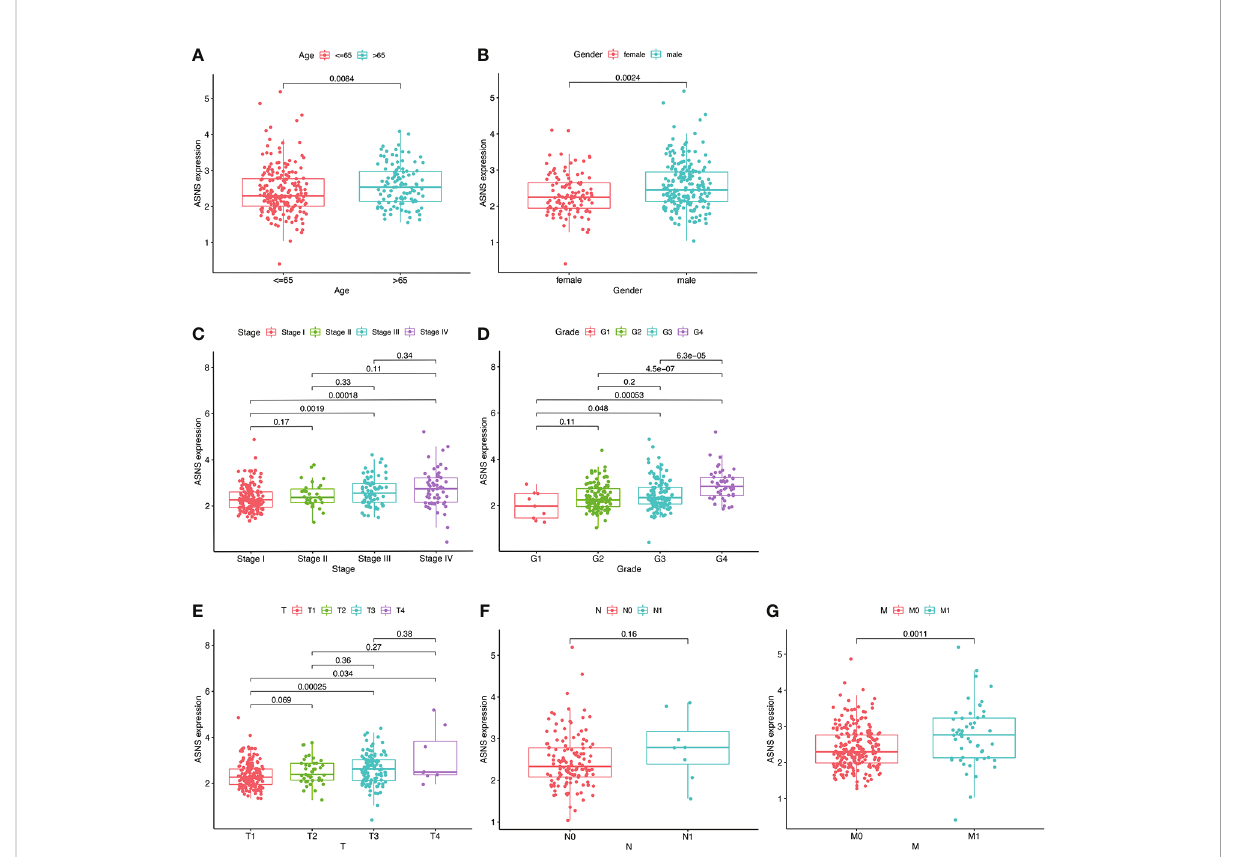
FIGURE 2 Expression pattern of ASNS in relation to several clinicopathological features. (A, B) ASNS expression in samples from patients strati fi ed by age and gender. (C – G) ASNS expression in samples strati fi ed by pathological stage, neoplasm histological grade, T stage, N stage, and M stage,